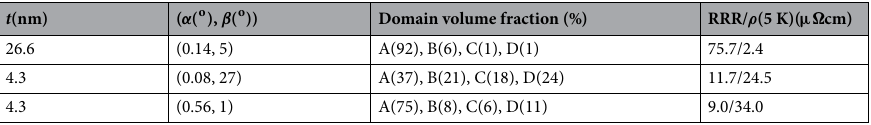
Table 1. Thickness and ( α , β ) dependents on domain volume fraction and RRR/ ρ (5 K). β represents the miscut direction, which is defined as the angle between the terrace edge and STO [010] c .